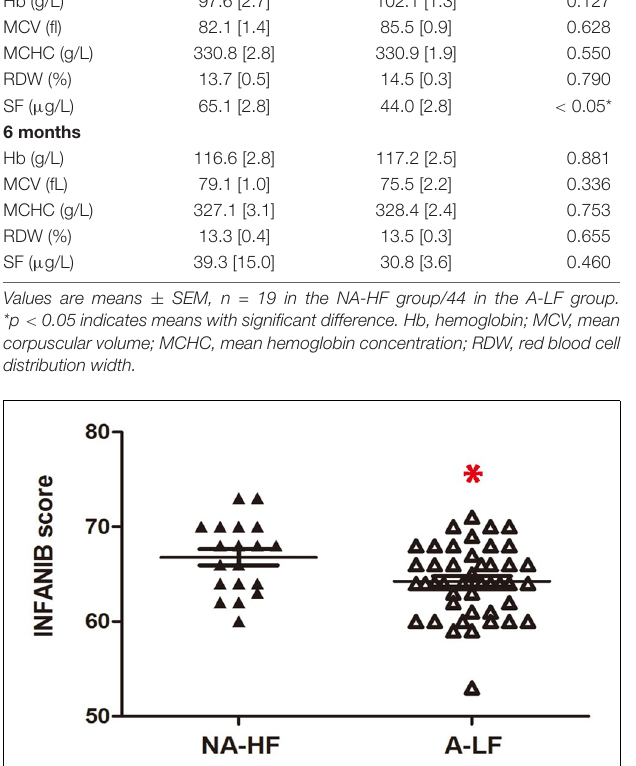
there was no significant correlation between the volumes of cerebellum/thalamus and the motor scores ( r =